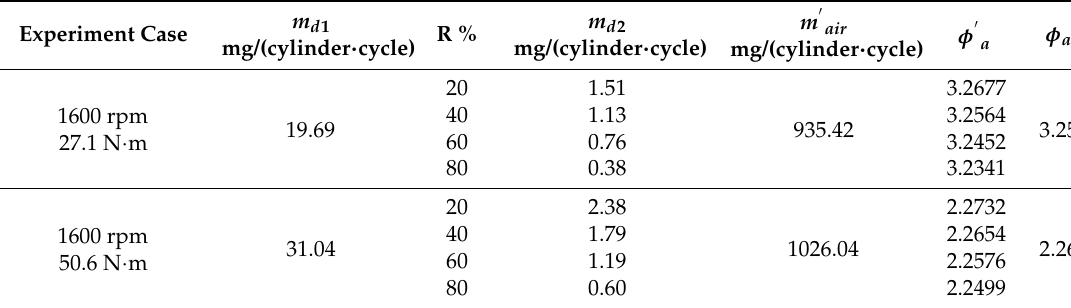
Table 4. Parameters’ values used in dual-fuel experiments.